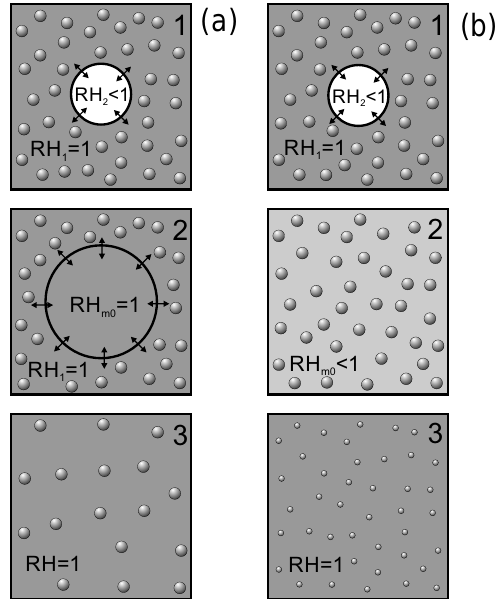
Figure 1. Classical conceptual diagram of (a) inhomogeneous and (b) homogeneous mixing. 1 – initial state; 2 – mixing state; 3 – final